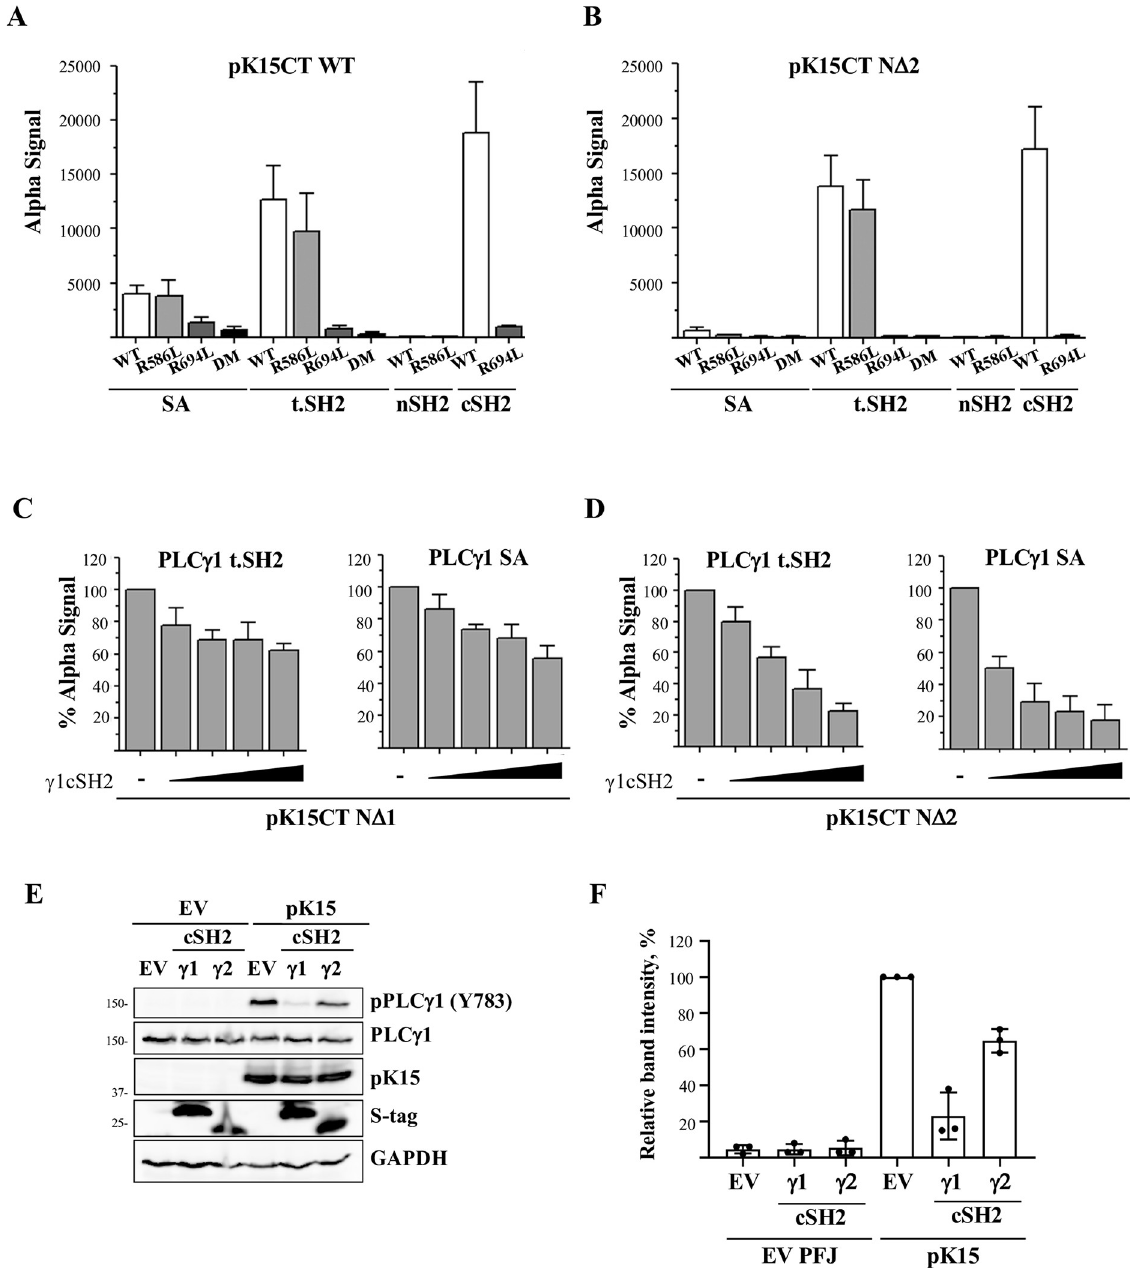
Fig 4. The PLC γ 1 cSH2 domain is required for the binding of PLC γ 1 to phosphorylated pK15 in vitro and may serve as a dominant- negative inhibitor. GST-fused pK15 cytoplasmic tail WT (A), or its truncated mutant N2 [51] (B), were phosphorylated in vitro by 2xStrep- Src and an AlphaLISA was performed with the indicated His-tagged fragments of PLC γ 1. Mean and standard deviation from at least two independent experiments with two technical replicates each are depicted. GST fusion proteins of the N1 (C) or N2 (D) truncation mutants of the pK15 cytoplasmic tail [51] were phosphorylated in vitro by 2xStrep-Src and their interaction with recombinant purified PLC γ 1 tSH2 (tandem SH2) or SA ( γ -specific array) domains was measured by AlphaLISA in the presence of increasing concentrations (300 nM, 600 nM, 900 nM, 1200 nM) of the purified PLC γ 1 cSH2. Mean and a standard deviation from at least three independent experiments with two technical replicates each are depicted.–: empty vector (pTriex4). (E) An expression vector (PFJ) expressing full length pK15 or empty PFJ (EV) were co-transfected in HEK-293T cells together with the isolated cSH2 domains of PLC γ 1 or PLC γ 2 or their empty vector pTriex4. After 48h lysates were collected and analysed by Western blot using an antibody to PLC γ 1 pY 783 to assess the level of PLC γ 1 phosphorylation. (F) The intensities of the pPLC γ 1 bands shown in panel E were quantified by densitometry, normalized to the values obtained with the empty vector (EV) in the presence of pK15, and plotted as relative values. The diagram shows the results obtained in three independent experiments.